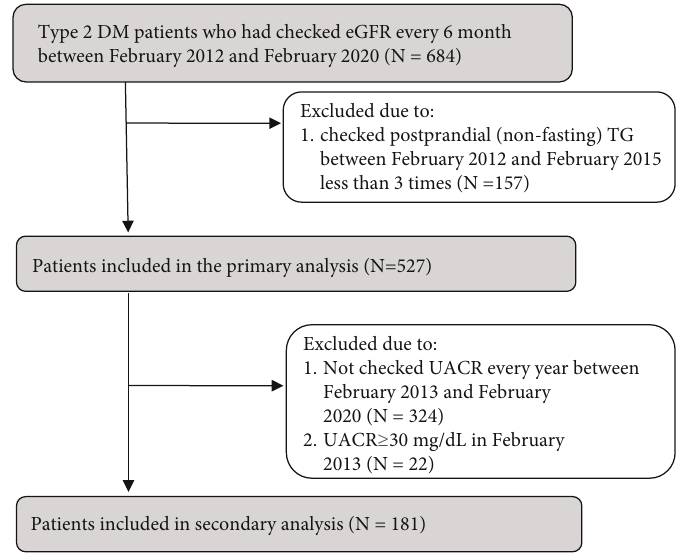
Figure 1: Study fl ow. After excluding subjects who did not meet our study criteria, a total of 527 participants were included in the primary analysis, and a total of 181 participants were included in the secondary analysis. DM: diabetic mellitus; eGFR: estimated glomerular fi ltration rate; TG: triglyceride; UACR: urine albumin-to-creatinine